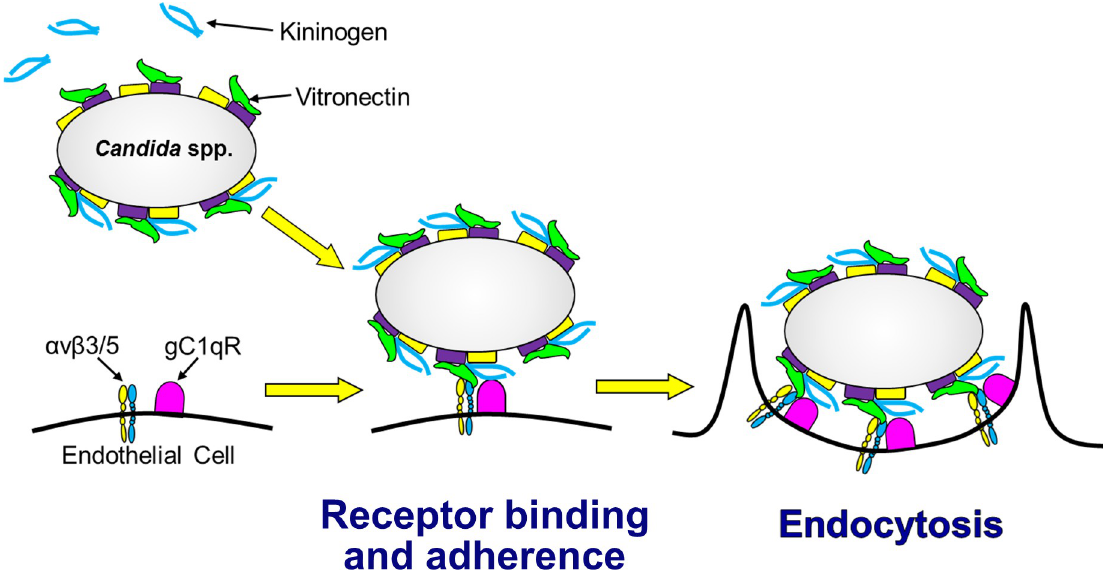
Fig 7. Model of how kininogen and vitronectin function as bridging molecules that bind to Candida spp . and induce endocytosis by human endothelial cells. Vitronectin binds to the surface of the organism, which enhances the binding of kininogen. When the organism comes in contact with the endothelial cell, vitronectin interacts mainly with the integrins α v β 3 and α v β 5 and whereas the vitronectin- kininogen complex interacts with both the α v integrins and gC1qR on the endothelial cells surface. These interactions mediate the adherence of the fungus to the endothelial cells and induce the endothelial cells to endocytose the organism.